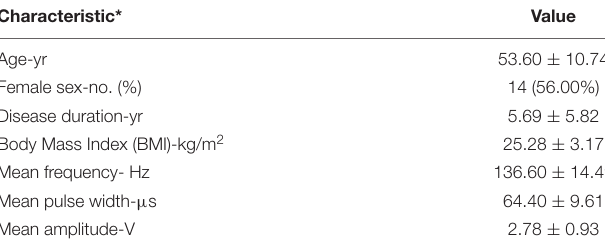
TABLE 1 | Baseline patient